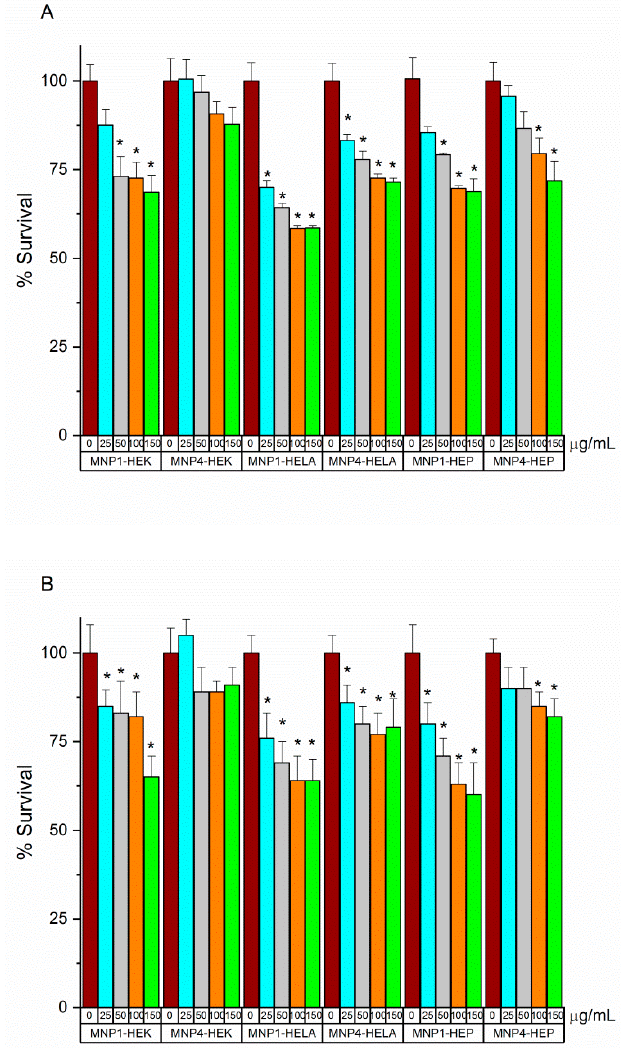
Figure 6. Cytotoxicity assays of MNP-1 and MNP-4 against HEK, HeLa, and HepG2 cells, incubated with increasing concentrations of the MNPs for 24 h. Results are means ± 1 standard deviation ( n = 6). * p < 0.05 vs. control cells (incubated in the absence of nanoparticles). ( A ): 24 h incubation time; ( B ): 48 h.